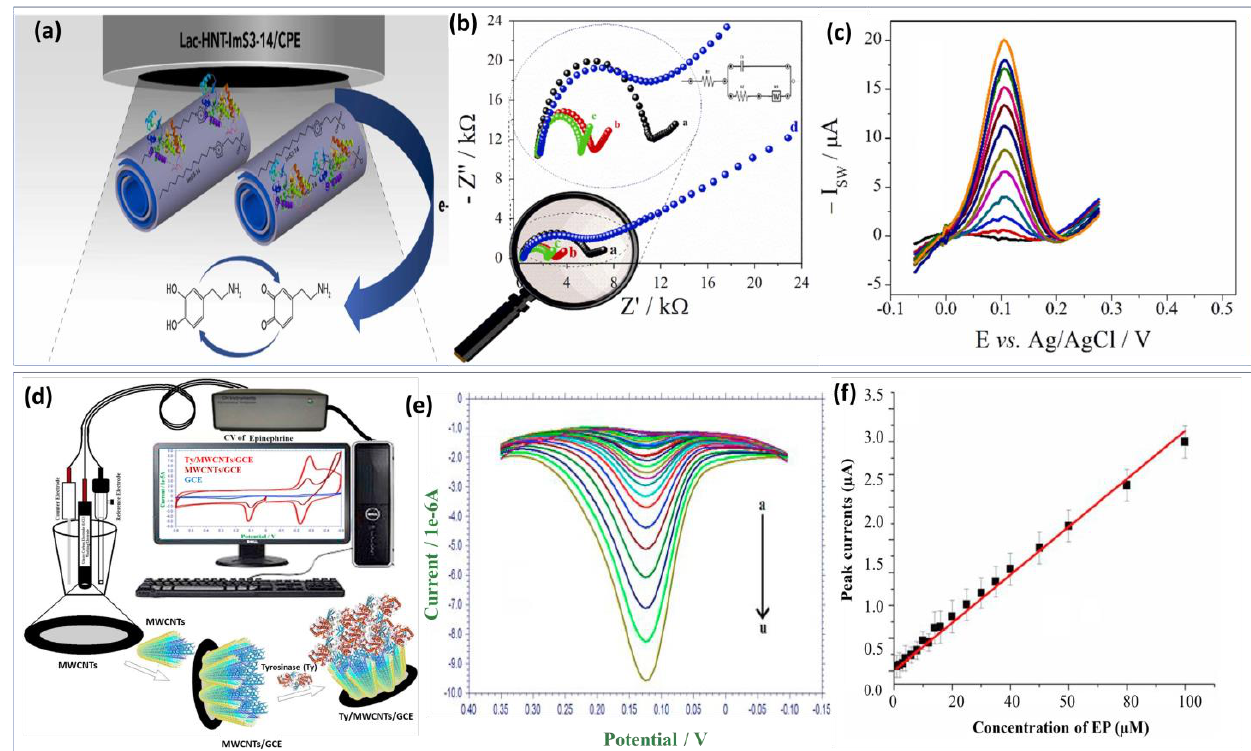
Figure 6. Enzyme based biosensor examples: ( a ) Schematic illustration of the biosensor based on laccase − halloysite nanotubes combined with imidazolium zwitterionic surfactants for dopamine detection. ( b ) EIS spectra in 5 mM [Fe(CN) 6 ] 3 − /4 − prepared in KCl for different functionalization steps. ( c ) SWV curves obtained after incubation of different DA concentrations. Reproduced with permission from [146]. Copyright 2023, Elsevier. ( d ) Biosensing platform for epinephrine monitoring based on multi walled carbon nano tubes mediated tyrosinase enzyme. ( e ) DPV curves obtained at Ty/MWCNTs/GCE for different EP concentrations ranging from 3 µ M to 200 µ M. ( f ) Calibration curve of the obtained biosensor showing good sensitivity and reproducibility. Reproduced with permission from [147]. Copyright 2023,